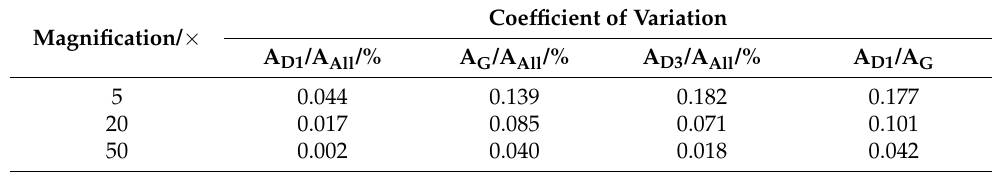
Figure 4. Raman characteristic parameters of char1 with a particle size of 61–75 µ m for different objective lens magnifications. Table 3. Variation coefficients of Raman characteristic parameters of char1 under different lens